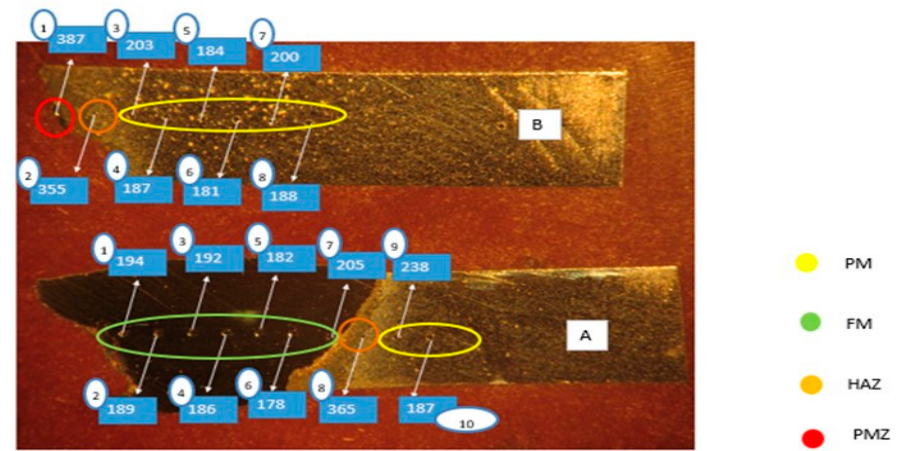
Figure 9. Indentations in sample 1P0W2P400 (PM–parent metal, FM–filler metal, HAZ–heat-affected zone, PMZ–partially melted zone) (values in HV).